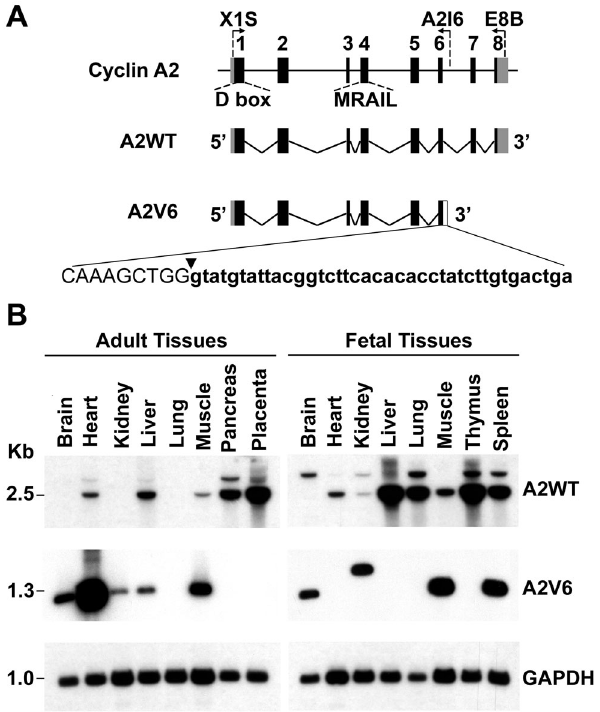
Figure 1. Distribution of the A2V6 splice variant of cyclin A2 in human tissues. ( A ) Exon-Intron organization of the Human cyclin A2 gene. Black boxes: exons. Grey boxes: 5 9 and 3 9 UTR. D-box: destruction box. MRAIL: CDK2 binding motif belonging to the cyclin box. Cyclin A2: gene. A2WT: mature cyclin A2 messenger resulting from alternate RNA splicing and amplified using the X1S-E8B primer pair. A2V6: cyclin A2 splice variant mRNA retaining a portion of Intron 6 (empty box) amplified using the X1S-A2I6 primer pair. The indicated sequence comprises the last nine nucleotides of Exon 6 (uppercase letters) and the retained Intron 6 sequence (lowercase letters). ( B ) Gene-expression analysis of cyclin A2 using PCR-Southern blotting in human adult and fetal tissue samples from the indicated organs. A2WT: wild-type cyclin A2 mRNA (2.5 kb). The 3.3 kb PCR product was determined to be A2WT plus Intron-1 by sequencing. A2V6: cyclin A2 splice variant (1.3 kb). GAPDH: Glyceraldehyde-3-phosphate dehydrogenase (loading control).